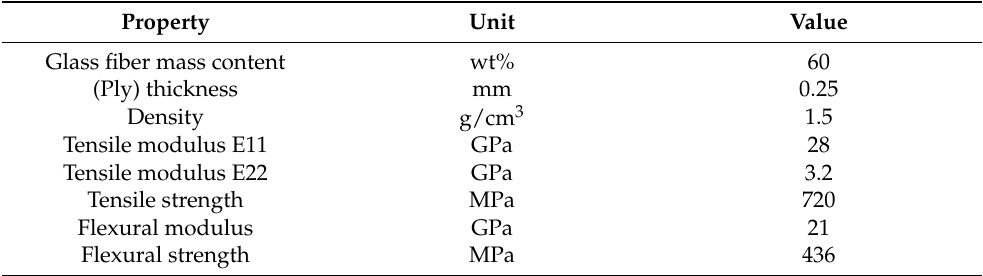
Table 1. Properties of the PP/GF60-UD unidirectional glass fiber-reinforced polypropylene tapes used for manufacturing of TPC laminates as provided by the supplier.